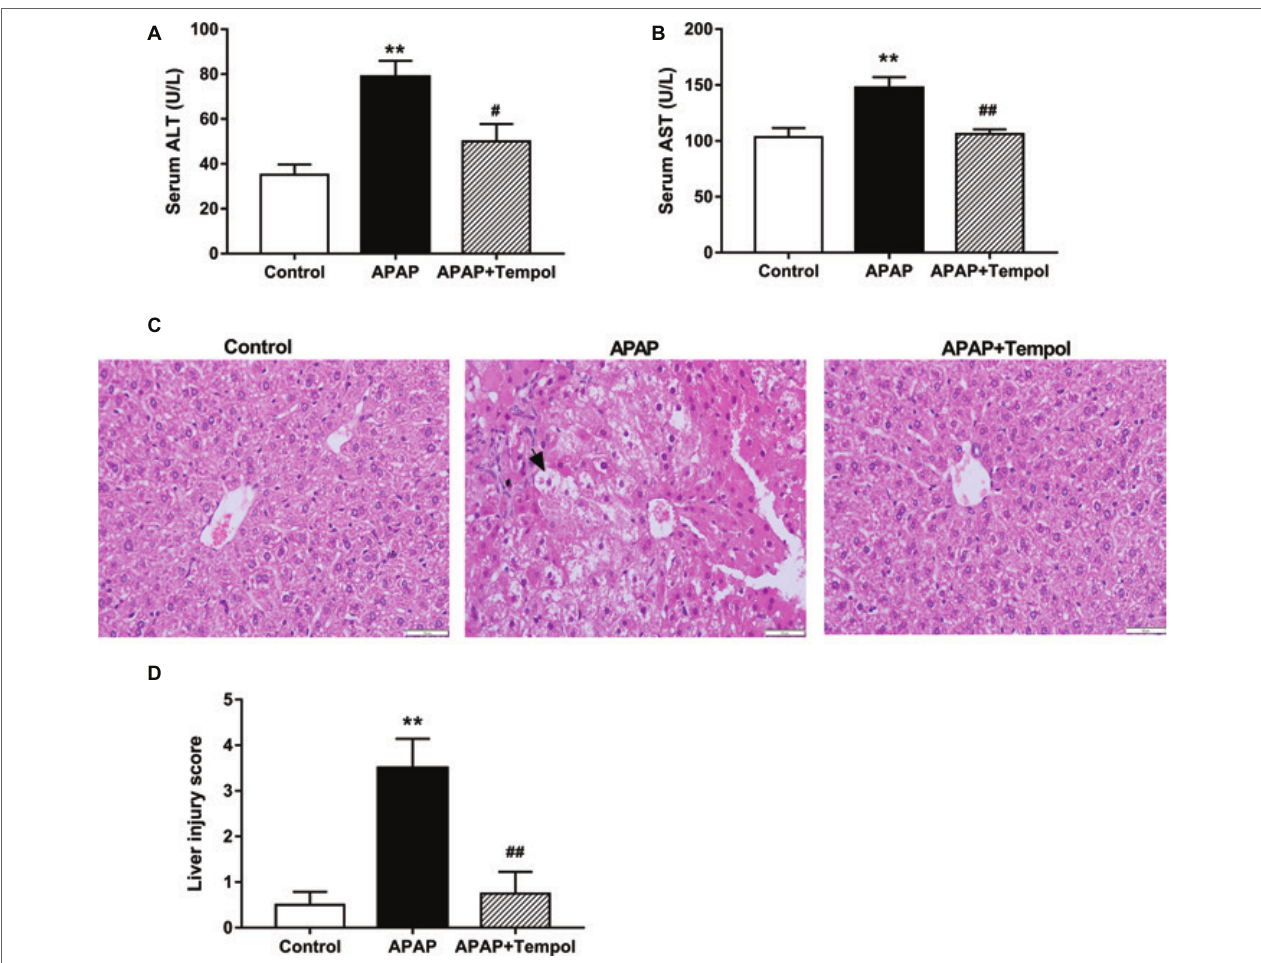
FIGURE 1 | Tempol administration ameliorates hepatocellular damage hepatocellular damage in acetaminophen-induced acute hepatotoxicity. (A) Levels of ALT in serum from the control mice (Control), vehicle-treated hepatotoxicity mice (APAP), and tempol-treated hepatotoxicity mice (APAP + tempol). (B) Levels of AST in serum from three groups. (C) H&E staining of hepatic tissues from three groups. Black arrows indicate hepatocyte necrosis. Scale bar = 50 μm. (D) Quantification of acute hepatic injury based on a semi-quantitative morphological scoring system from 0 to 5. Data are mean ± SEM. # p < 0.05 vs. APAP, ** p < 0.01 vs. control, ## p < 0.01 vs. APAP, n =